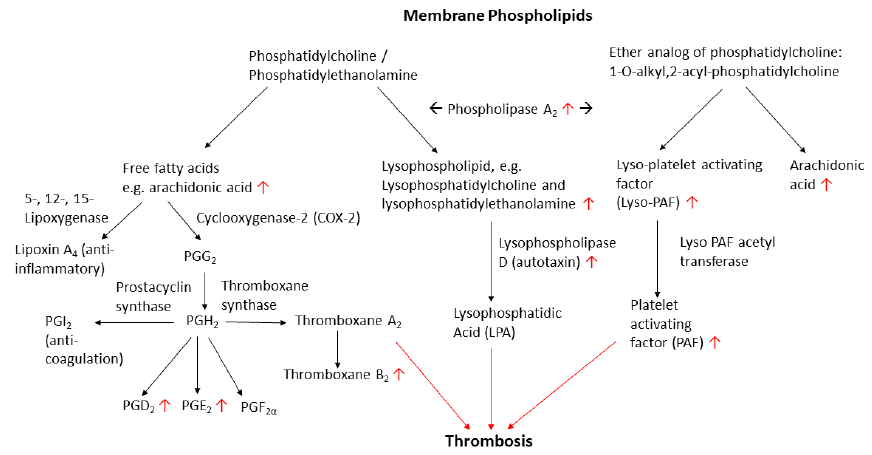
Figure 1. Phospholipid metabolites and pathways leading to thrombosis. Red arrows indicate enzymes and metabolites that are increased in the blood of COVID-19 patients (for details, please see text). 5. COVID-19-Associated Changes in Arachidonic Acid (ARA) and Docosahexaenoic Acid (DHA)